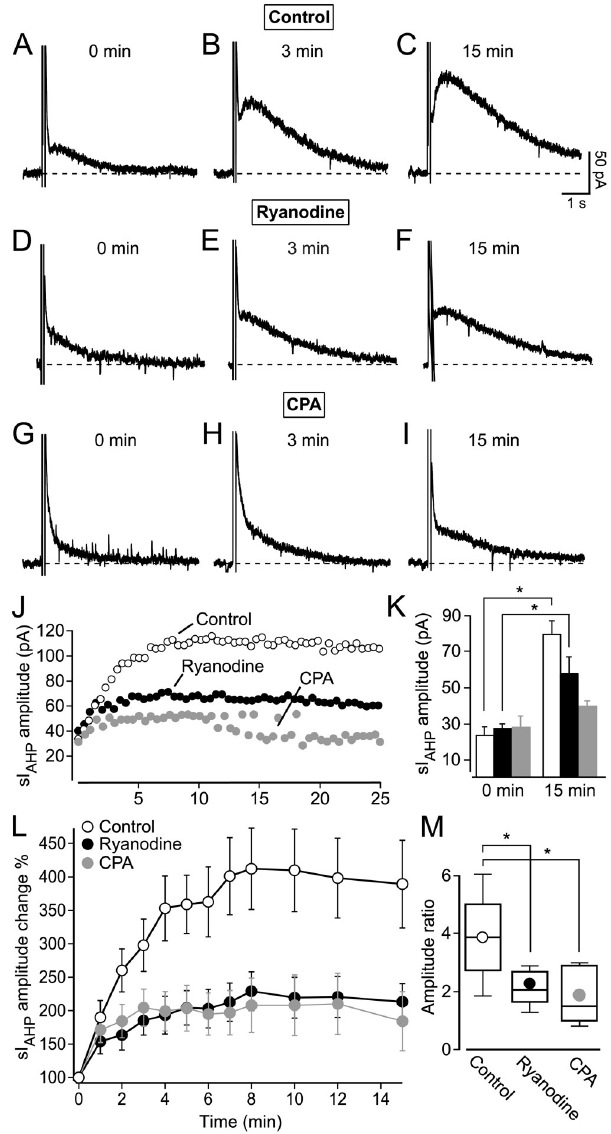
Fig 3. CICR contributes to the activity-dependent potentiation of sI AHP in rat CA1 pyramidal neurons. ( A-I) Representative current traces at 0 min, 3 min and 15 min show the potentiation of the sI AHP . ( A-C) Control traces recorded in the presence of 0.2% DMSO. ( D-F) Reduced potentiation of the sI AHP in the presence of 10 μ M ryanodine. ( G-I) Reduced potentiation of the sI AHP in the presence of 50 μ M CPA. ( J) Superimposed time-courses of three representative cells comparing the different degrees of the potentiation of sI AHP amplitude under control conditions, 10 μ M ryanodine and 50 μ M CPA. ( K) Bar chart summarizing the sI AHP amplitude at the beginning of the recording (0 min) and the end of the recording (15 min), (control, 0 min: 23.1 ± 5.1 pA; 15 min: 79.0 ± 7.7 pA; n = 5; paired t-test: P = 0.0017; 10 μ M ryanodine, 0 min: 27.4 ± 2.6 pA; 15 min: 58.2 ± 9.3 pA; n = 5; paired t-test: P = 0.02; 50 μ M CPA; 0 min: 27.5 ± 6.6 pA; 15 min: 39.2 ± 3.1 pA; n = 5; paired t-test: P = 0.12). ( L) Summary of the relative (%) time-courses of potentiation of sI AHP measured in all cells (n = 5 for each condition) under control conditions (0.2% DMSO), in 10 μ M ryanodine and in 50 μ M CPA. Reduction of the sI AHP amplitude potentiation in the presence of ryanodine (two-way ANOVA with post-hoc Bonferroni test: P < 0.0001) and of CPA (two-way ANOVA with post-hoc Bonferroni test: P < 0.0001). ( M) Ratio of the sI AHP amplitude measured at 0 and 15 min under control conditions (mean ± SEM: 3.9 ± 0.7; n = 5), in ryanodine (2.2 ± 0.3; n = 5; P = 0.04) and in CPA (1.9 ± 0.4; n = 5; P = 0.03).